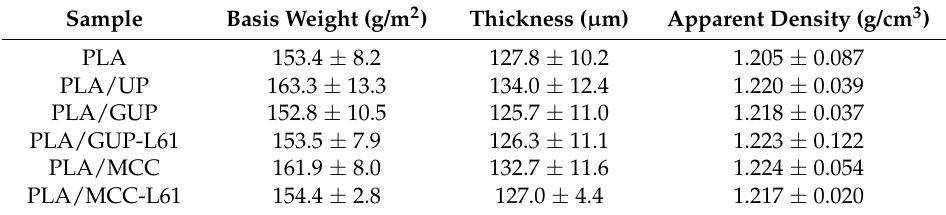
Table 5. Structural properties of PLA/cellulose biocomposite films (see Table 1 for sample identification).